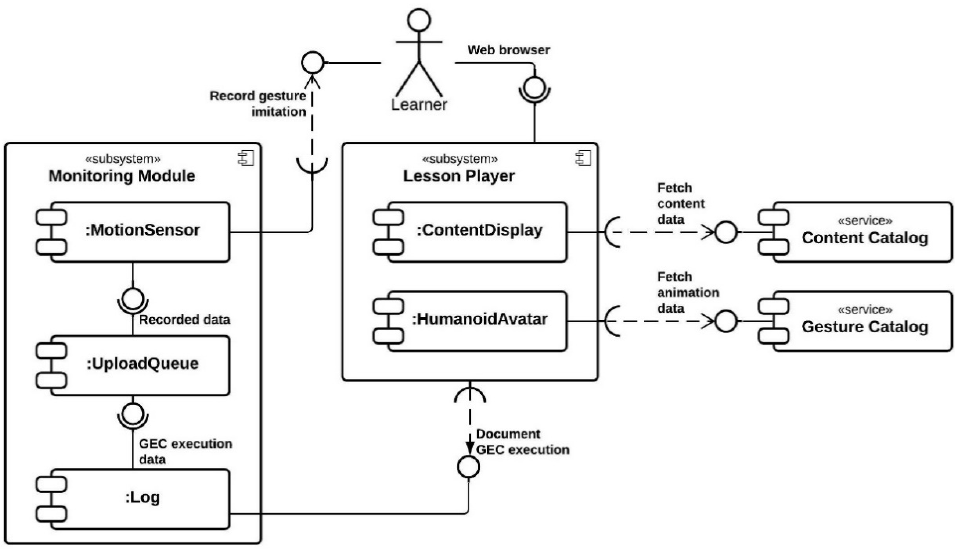
Figure 2. UML component diagram from the perspective of the learner.